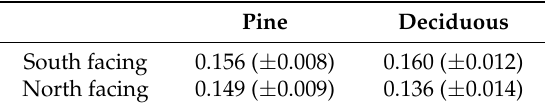
Table 3. Exponential decay rates of “slow” fraction.